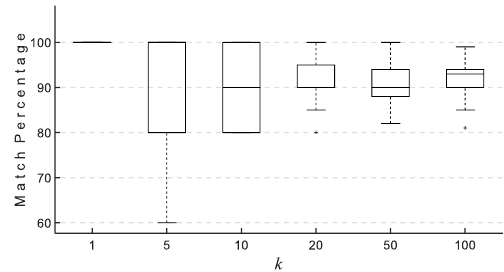
Figure 10 Match percentage of Postgres-v2 and MongoDB Unlike the comparison between the Postgres approaches, there is